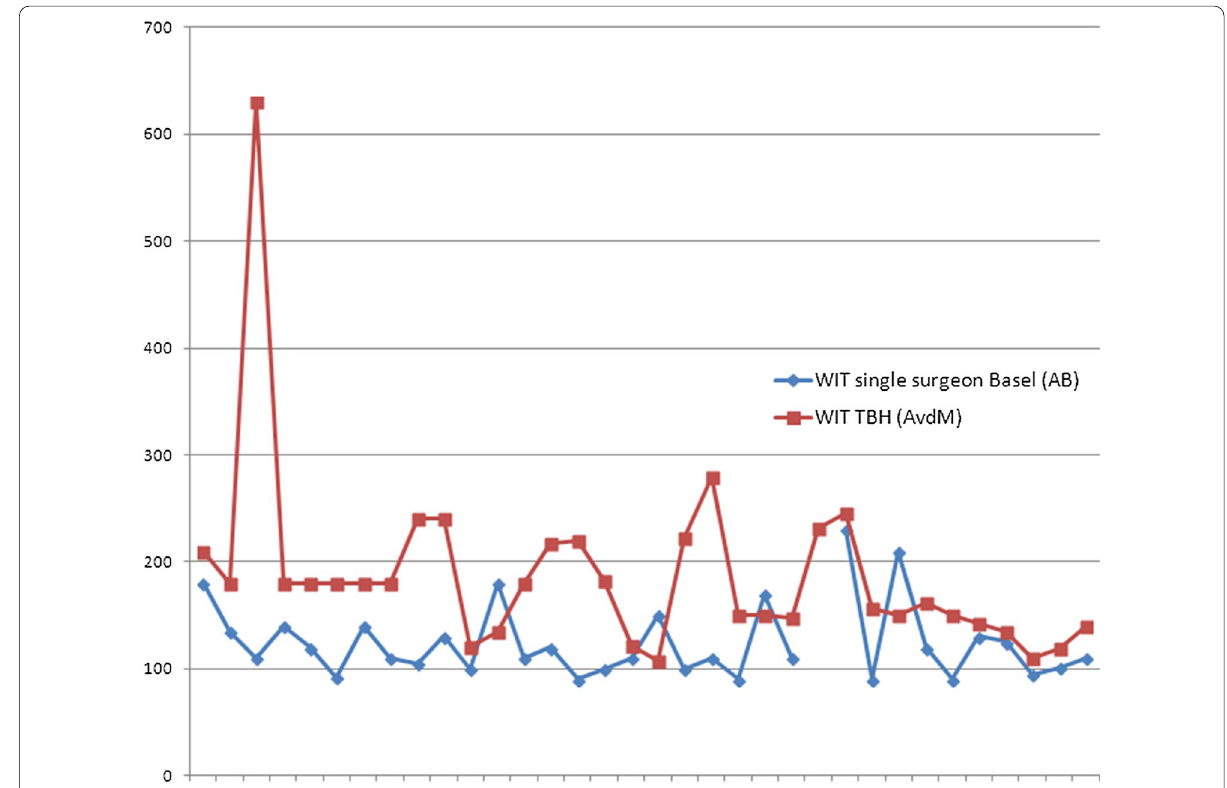
Fig. 3 Warm ischaemic times (WIT) of the Basel and Tygerberg single surgeons